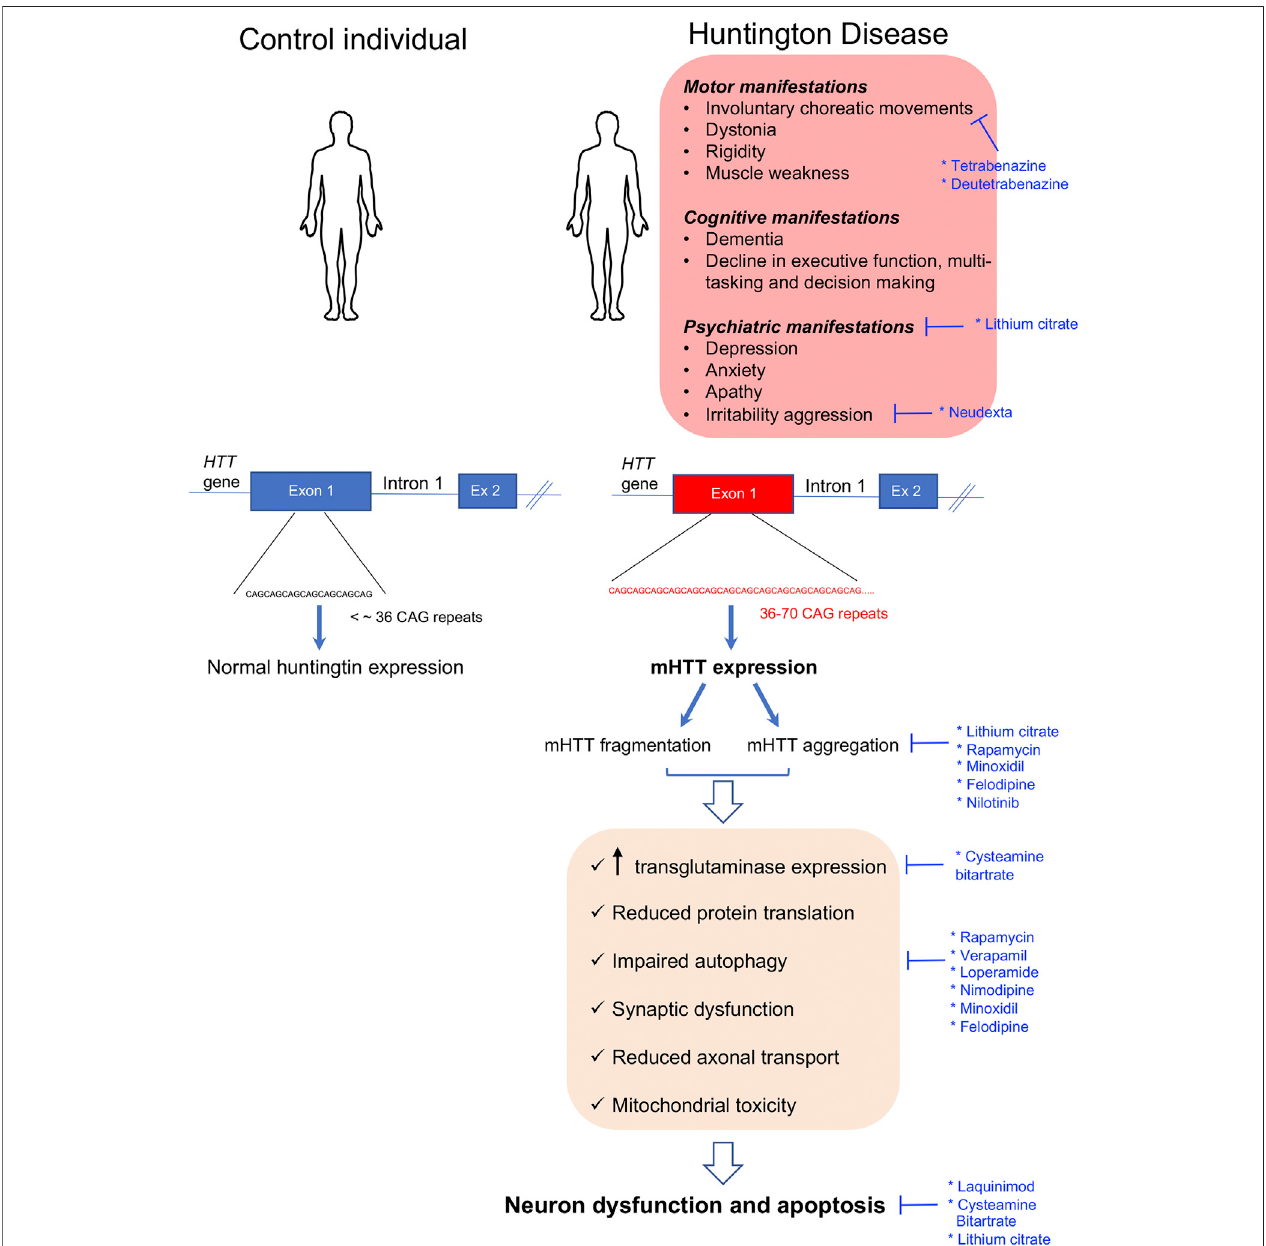
FIGURE 1 | Clinical manifestations and molecular disease mechanisms in Huntington ’ s disease. This pathology is caused by CAG repeat expansions in the fi rst exon of the HTT gene which result in the accumulation of mutant Huntington protein (mHTT) within the cells which causes a wide variety of cellular alterations leading to neuronal dysfunction and death. Repurposed drugs with and without orphan designation for Huntington ’ s disease are highlighted in blue along with the cellular dysfunctions or clinical manifestations that they tackle. Ex: exon.